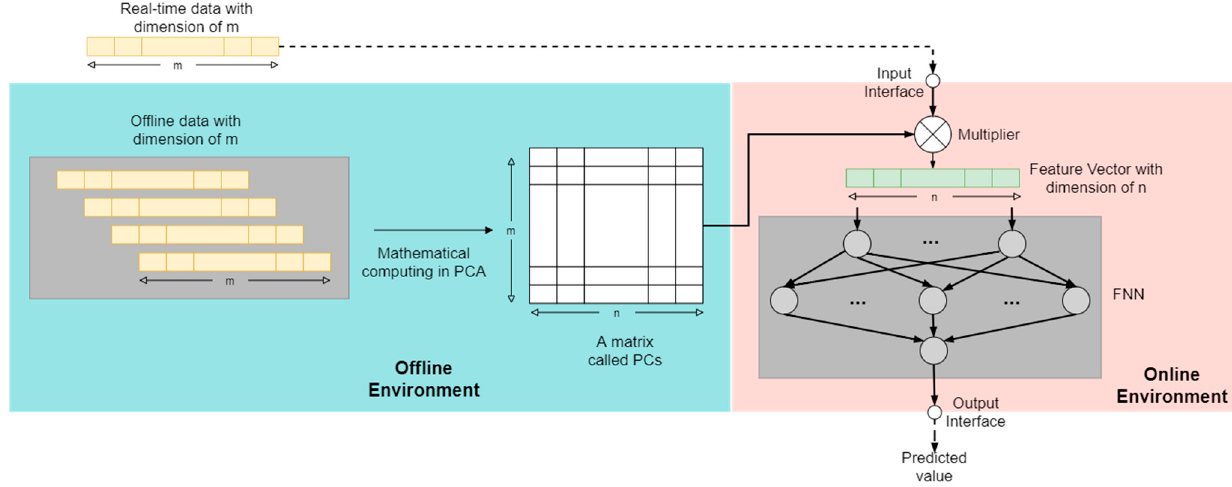
Figure 2. Theoretical framework of FNN with PCA. PCs is a matrix, which is the result of the mathematical computation and maps real-time data to the corresponding Feature Vector.